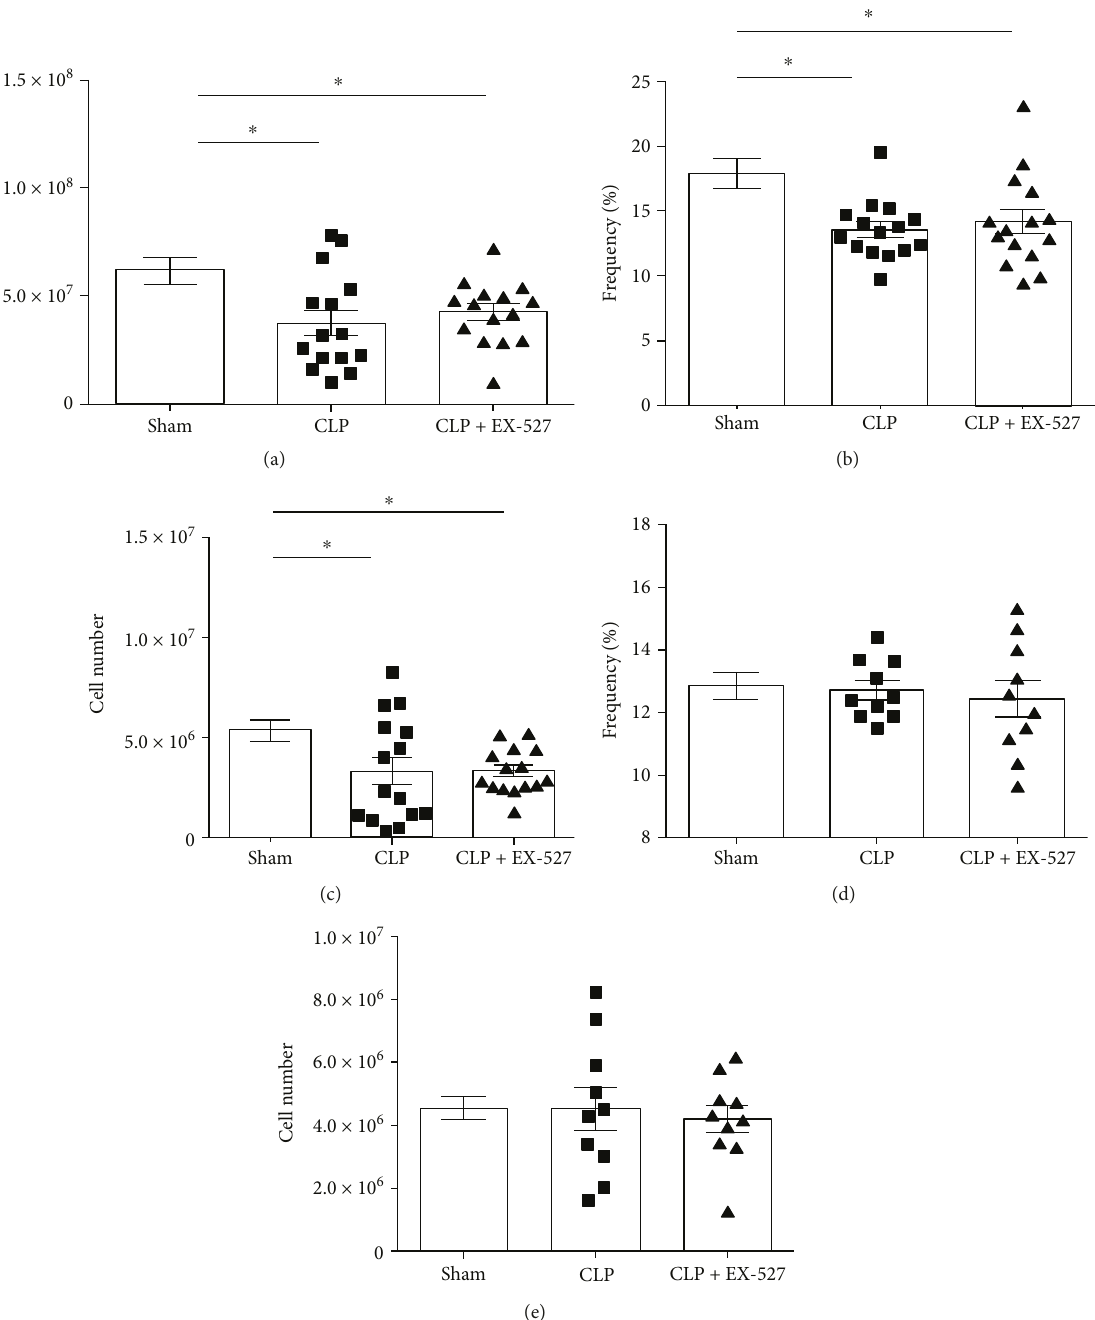
Figure 1: SIRT1 inhibition has no e ff ect on frequency and number changes in total splenocyte and CD4+ T cells during sepsis-induced immunosuppression. All data presented as sham versus CLP versus CLP+ EX-527. (a) Cumulative results of total splenocytes presented as total cell number. (b, c) Cumulative results from surface CD4 presented as (b) frequency of total splenocytes (%) and (c) absolute cell count. (d, e) Cumulative results from surface CD8 presented as (d) frequency of total splenocytes (%) and (e) absolute cell count. Data are representative of three independent analyses with a total of 5 mice in each group. Data are expressed as mean ± SEM. n = 15 mice/group. ∗ p < 0 05 to nontreated CLP mice ( p = 0 029 and p = 0 035 , resp.). increased in septic mice at 30 h compared to sham Importantly and concurrent with the shift away from (Figure 2(d); sham = 2.14 ± 0.12%, CLP =2.92 ± 0.1%; p = 0 0011 ). While TGF β was not signi fi cantly increased during CD4+ anti-in fl ammatory cytokine production, SIRT1 inhi- bition increases in the frequency of IFN γ cytokine produc- sepsis (Figure 2(c)), EX-527 signi fi cantly decreased TGF β tion in CD4+ T cells, compared with CLP (Figure 2(b); (Figure 2(c)) and IL10 (Figure 2(d)) frequency compared